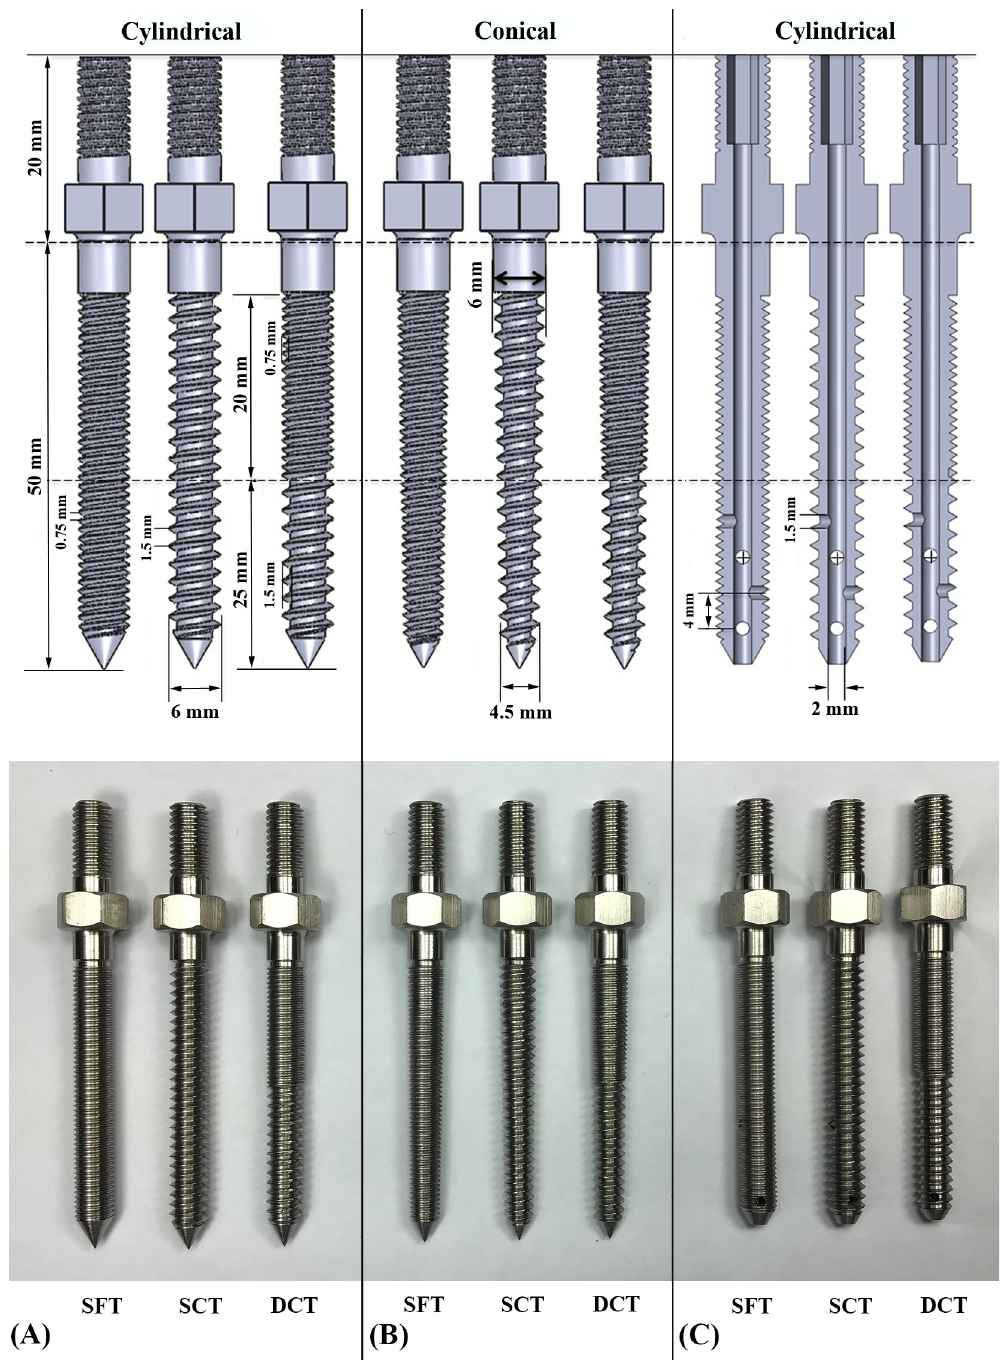
Fig 1. Schematic drawings (upper) and photographs (bottom) showing nine types of pedicle screws with SFT, SCT, and DC/DT thread profiles. (A) Solid cylindrical screws; (B) solid conical screws; (C) cannulated cylindrical screws. ( � represents a radial hole directed outward from the paper, with dimensions in